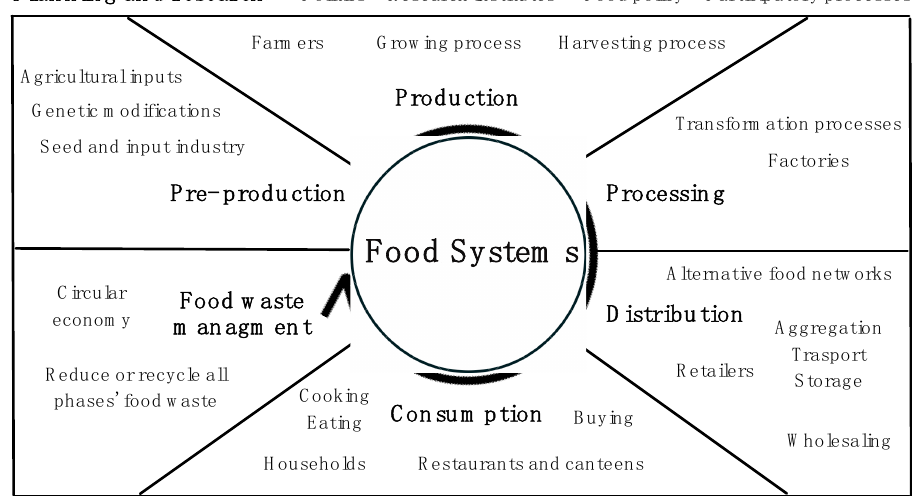
Figure 2. The food system phases elaborated by the authors.